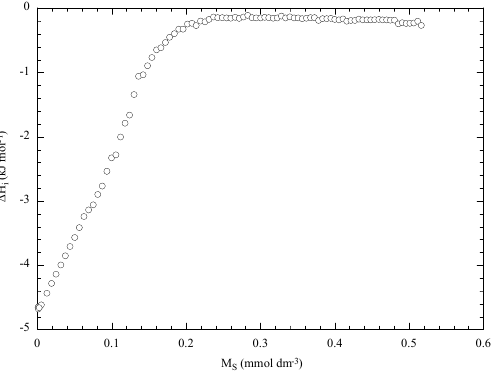
Figure 7. Enthalpy per injection for the water+EO copolymer concentration at 303 K. The CMC is 3x10 -3 mmol dm -3 . Data are from Ref.